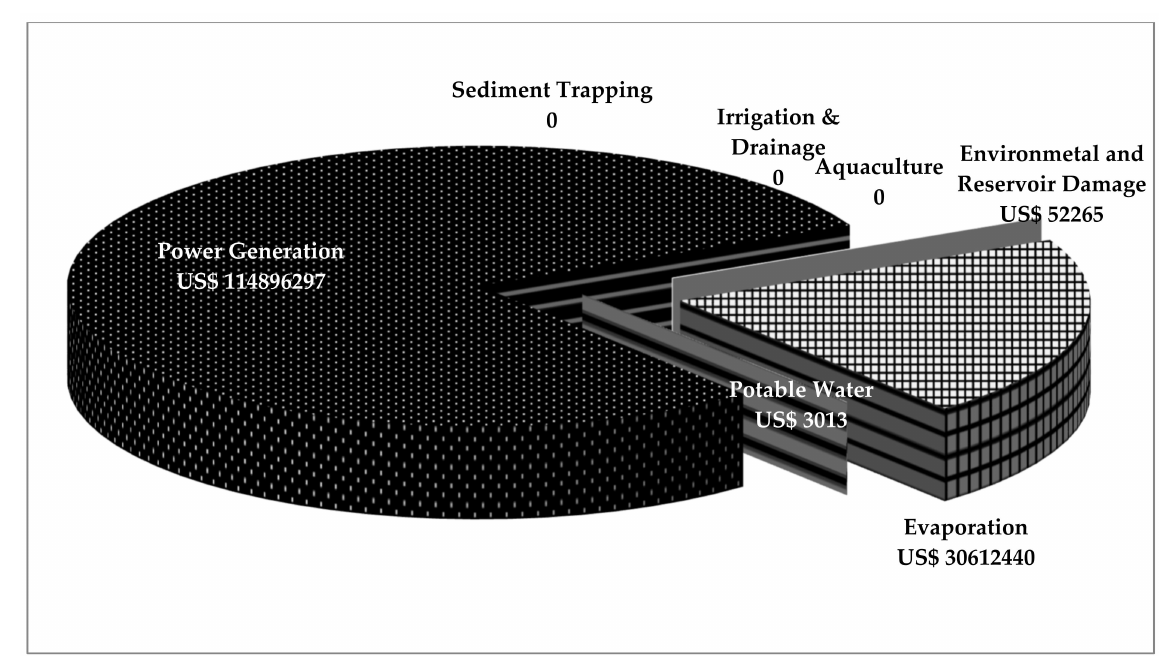
Figure 3. Total costs of constructing Bakhtiari